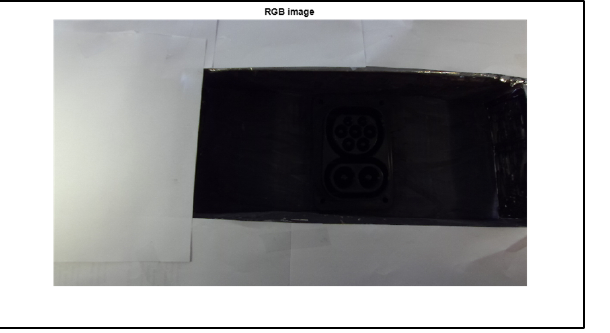
Figure 11. ( a ) LED lights regulation circuit and ( b ) experiment setup.